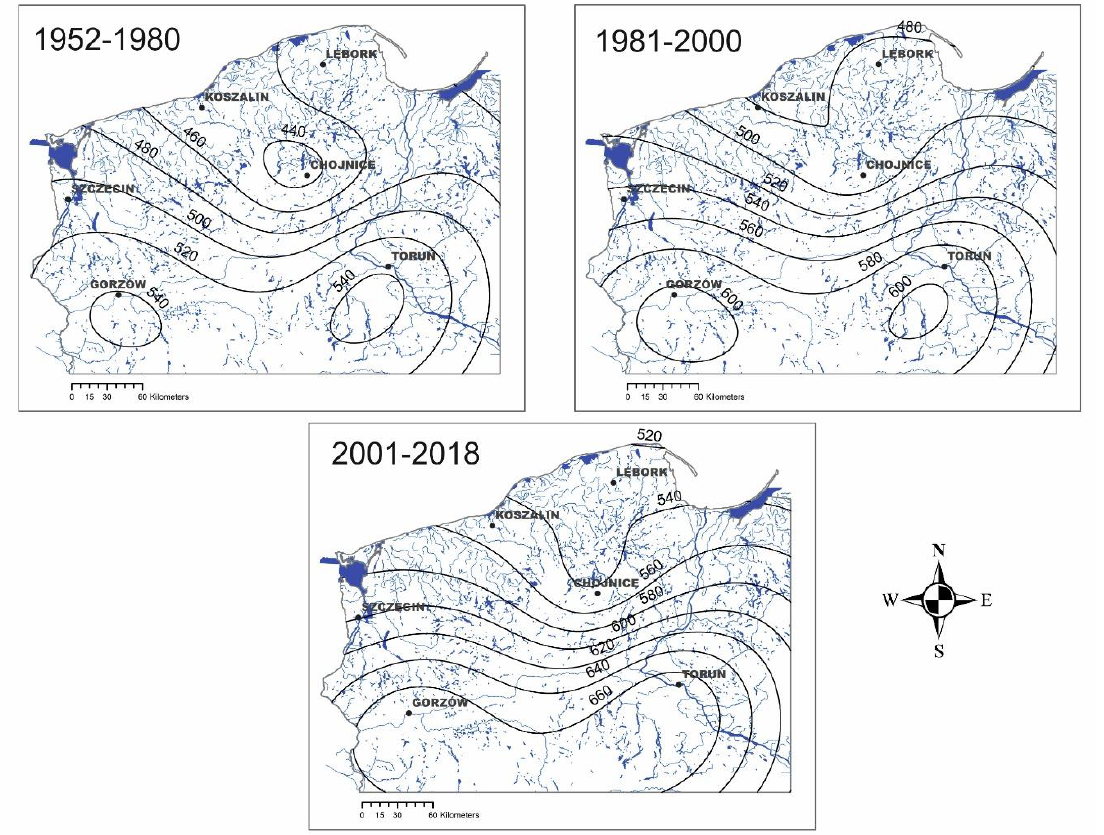
Figure 6. Spatial distribution of average annual sums of potential evaporation in north-western Poland divided into the periods 1952–1980, 1981–2000 and 2001–2018 against the distribution of the water network (calculated based on data obtained from the Polish Institute of Meteorology and Water Management—National Research Institute [43], water network based on [41]).